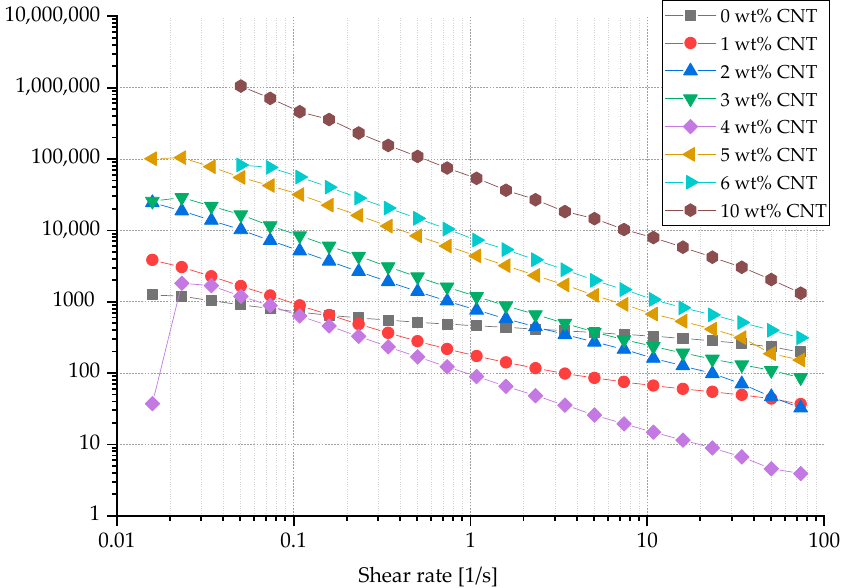
Figure 3. Viscosity of compounds with different carbon nanotube (CNT) contents, measured at a constant temperature of 200 °C.